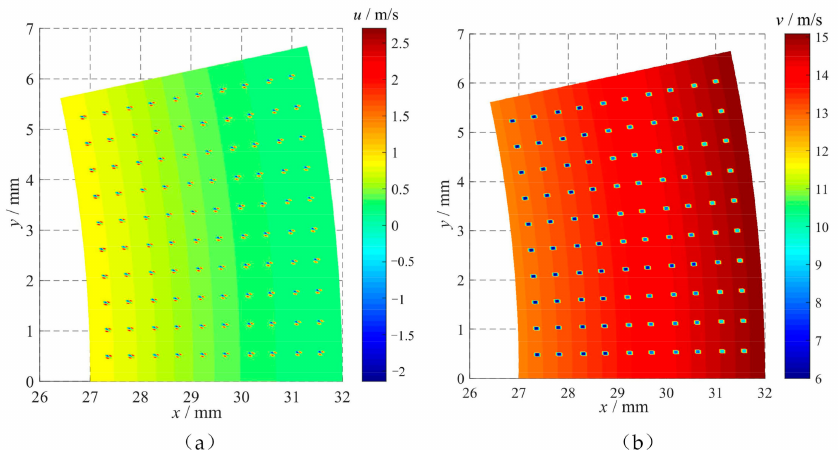
Figure 8. Velocity field of oil film with uniformly distributed hexahedron textures (( a ) is radial velocity; ( b ) is angular